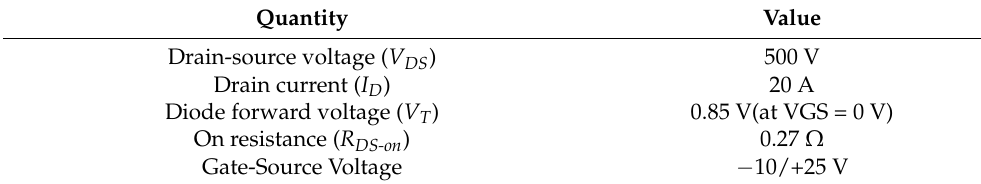
Table 3. IRFP460 datasheet